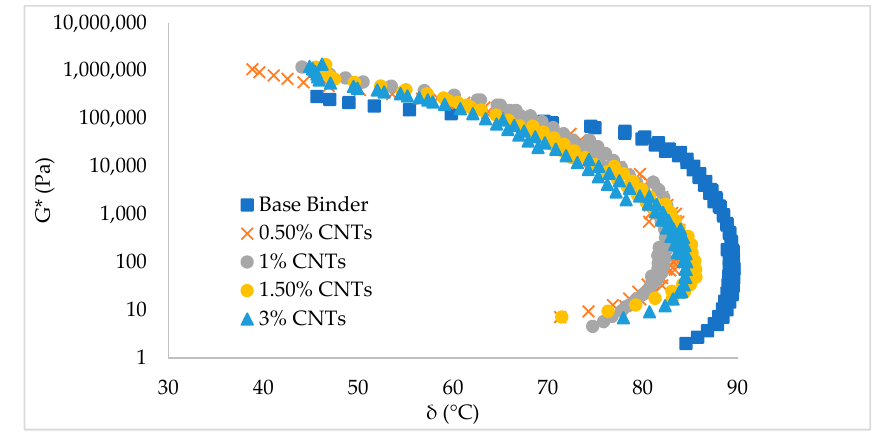
Figure 15. Black diagram for unmodified and CNT-modified binder.